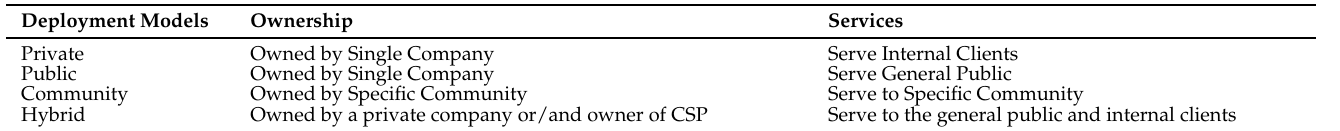
Table 2. Summary of CC deployment